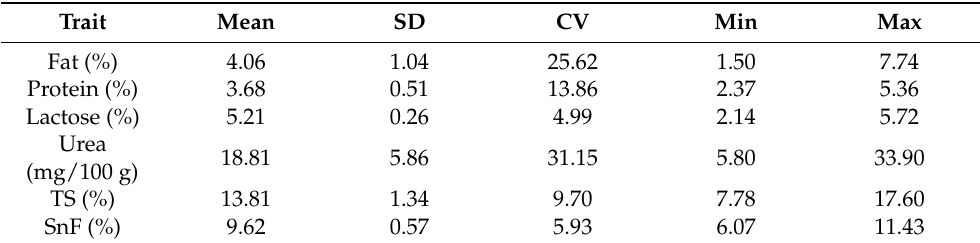
Table 1. Descriptive statistics of the milk